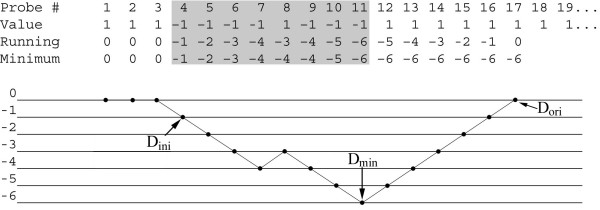
An illustration of the random walk. A region is defined by Dini and Dmin, shown here as a shaded area spanning probes 4–11.